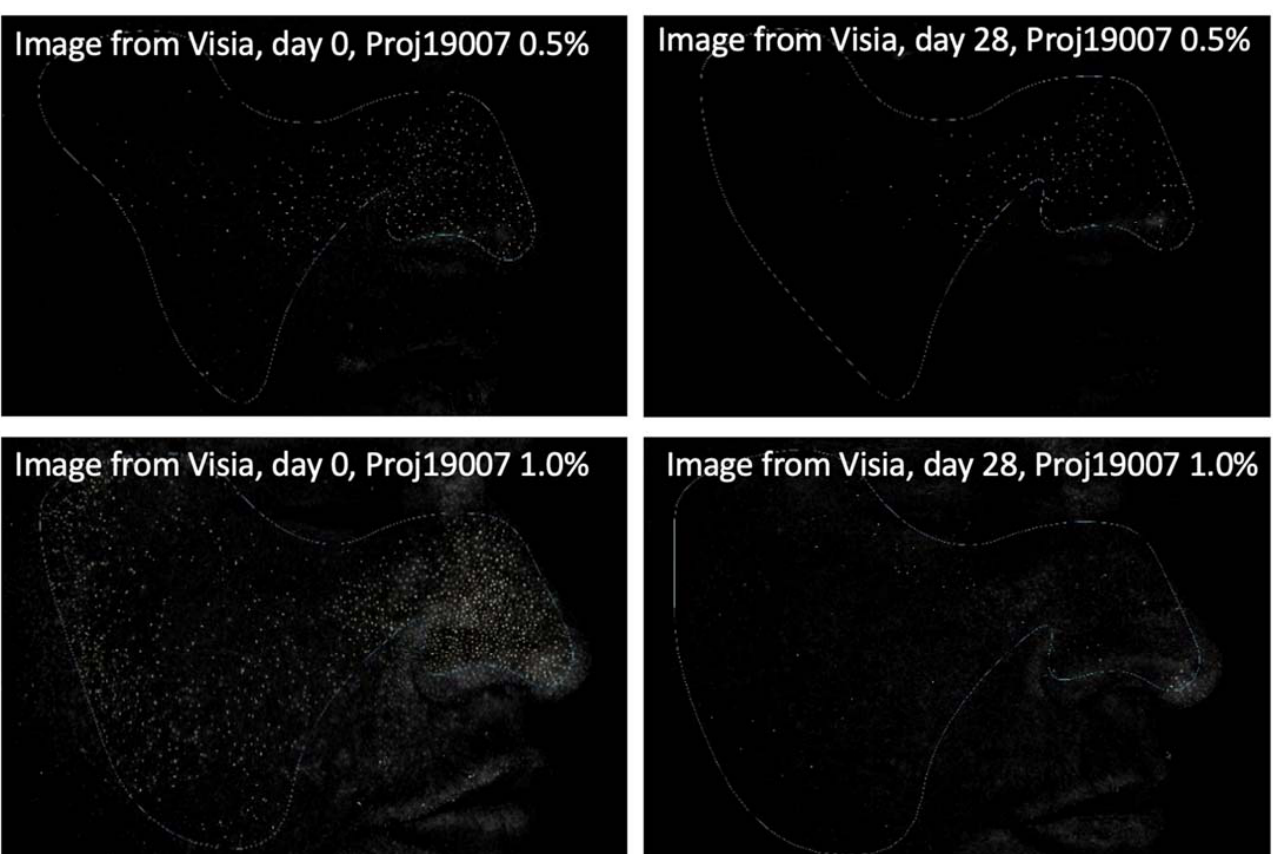
Figure 4. Images (Visia ® ) from two participants illustrating the porphyrin reduction after 28 days of treatment with PXCA 0.5% and 1.0%.